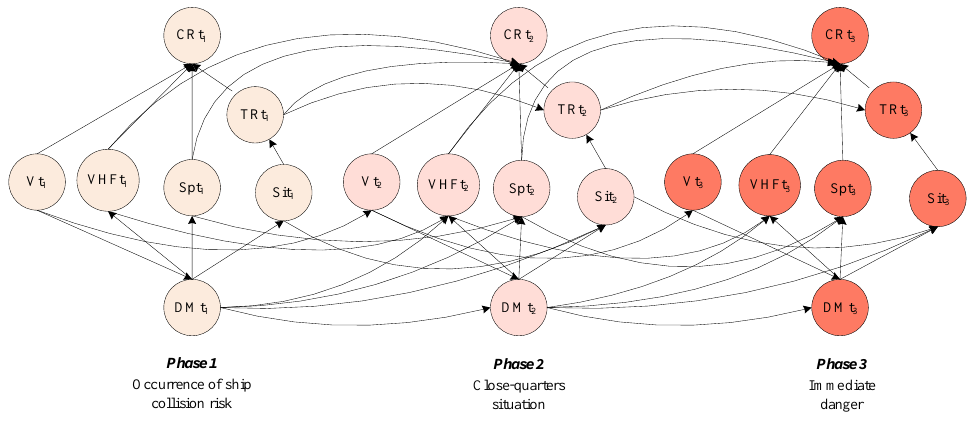
Figure 6. The structure of the DBN model.